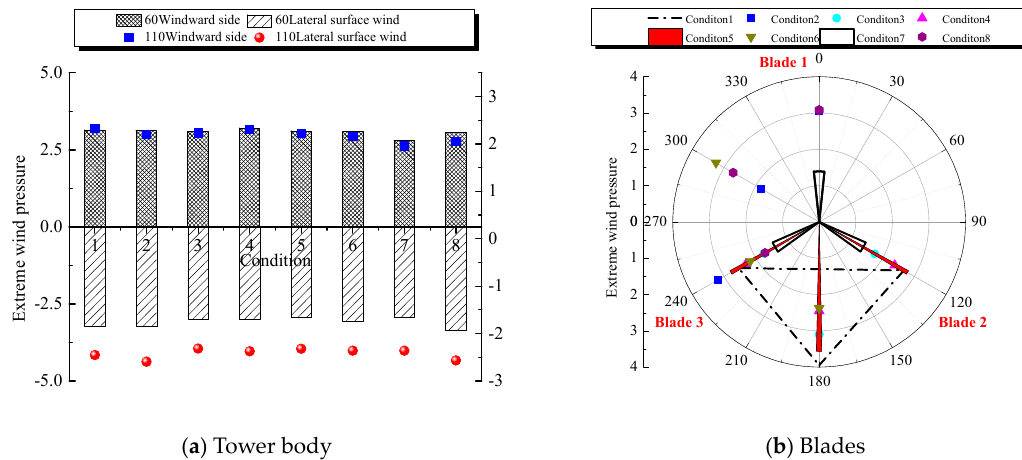
Figure 17. Extreme wind pressure distributions on the tower body and blades under different conditions.